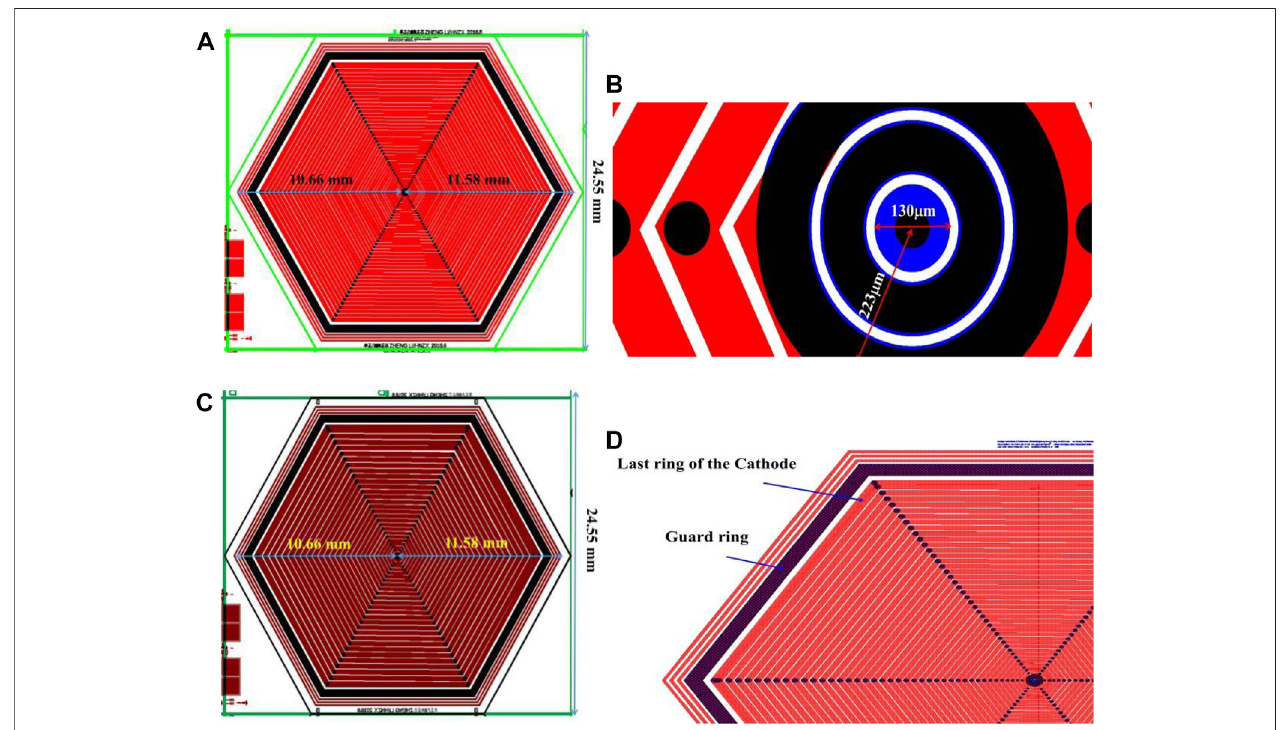
FIGURE2| Designdetailsofthe314mm 2 DSSH-SDD. (A) Thedetailandthesizesofthefrontside; (B) thedetailandthesizesofthebackside; (C) thesizesofthe front anode electrode and the front fi rst cathode electrode; and (D) the last ring of the front cathode and the cathode guard rings.